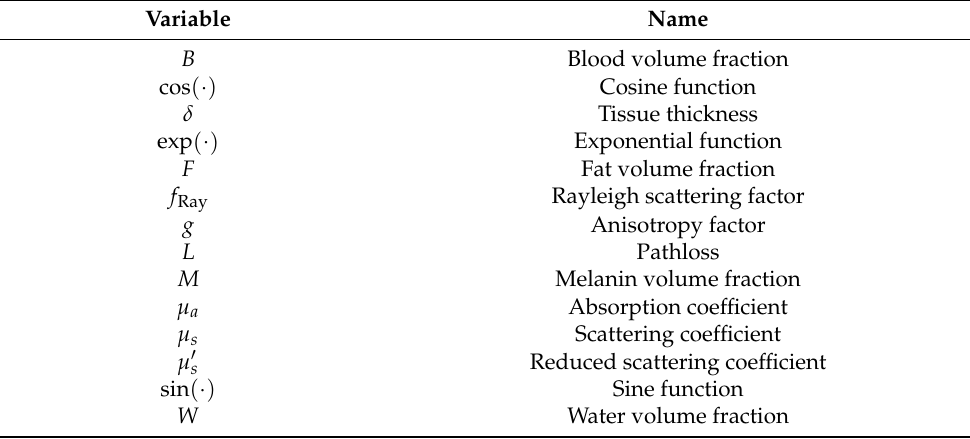
Figure 1. The structure of this paper. Table 1. Table of